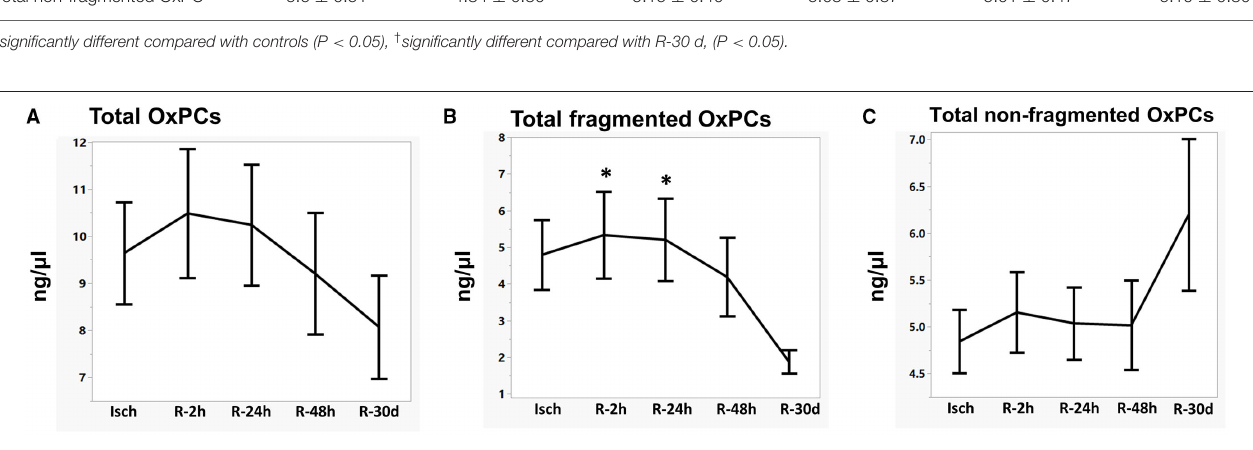
Frontiers in Medicine |